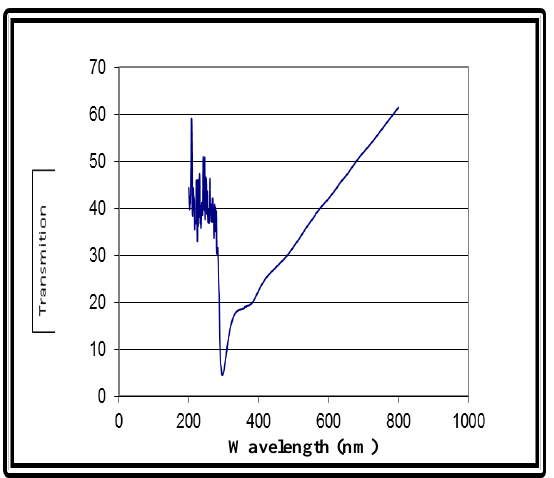
Fig. 5: UV-VIS transmition spectrum of copper oxide thin film.